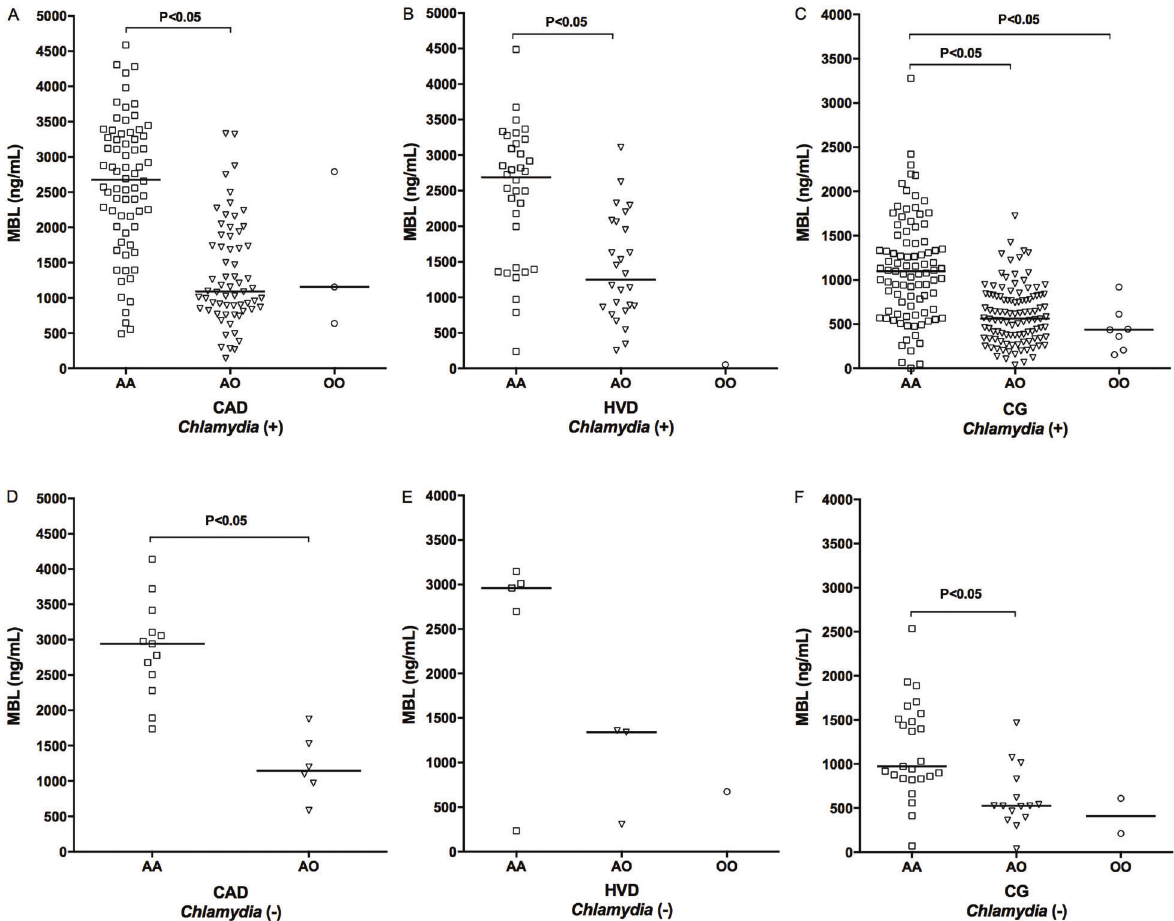
Figure 2. Distribution of mannose-binding lectin (MBL) plasma levels in relation to the different genotypes of ( A ) patients with coronary artery disease undergoing coronary artery bypass surgery (CAD), ( B ) patients with heart valve disease undergoing valve replacement (HVD), and ( C ) control subjects (CG) seropositive for Chlamydia, and seronegative for Chlamydia ( D , E and F ). Data are reported as medians (Mann-Whitney